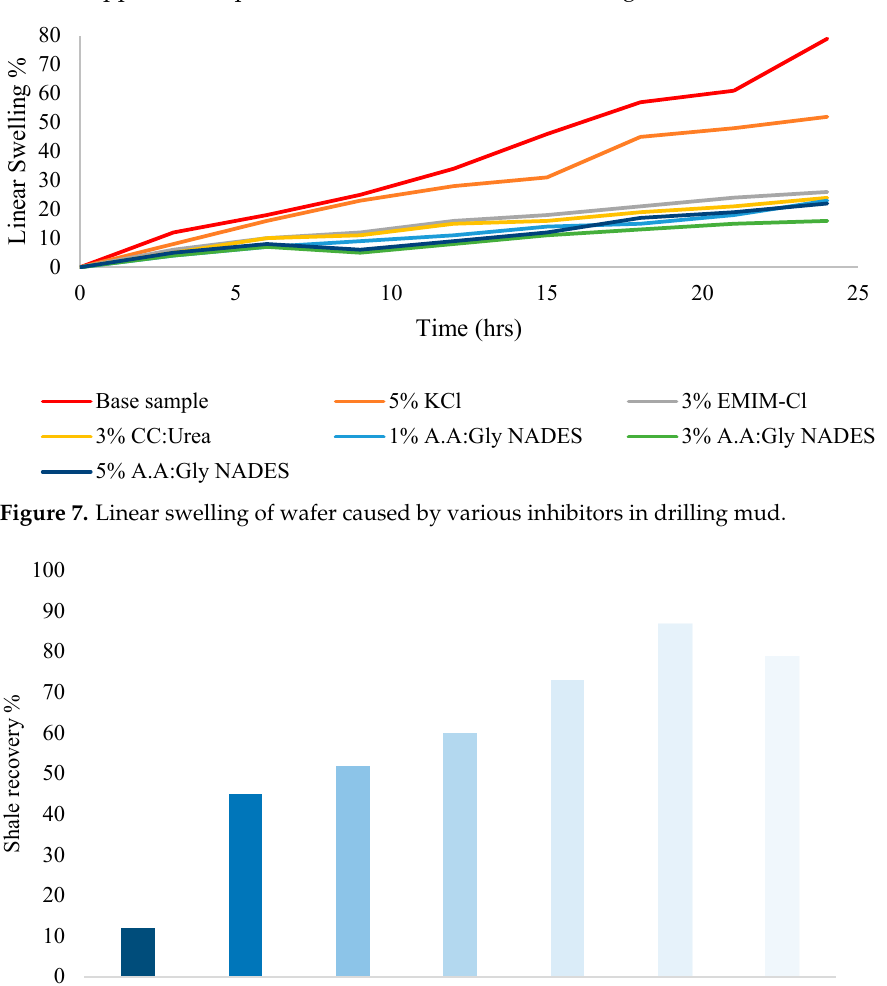
10 of 18 Figure 6. Comparison of mud cake thickness of NADES-based mud with other inhibitors. 3.4. Linear Swelling and Shale Recovery Tests The change in linear swelling for AA:Gly-NADES-based mud samples with different concentrations and KCl (5%), EMIMCl (3%), CC:Urea (3%)-based mud were evaluated and compared to the base drilling fluid sample. Figure 7 shows that the base sample (with no NADES) results in 72% linear swelling. The addition of NADES in the mud significantly reduced the linear swelling to 16% and the best results were obtained when 3% NADES was added to the drilling mud, resulting in only 16% swelling or 77.77% inhibition. Figure 8 illustrates the results for shale recovery. The presence of illite